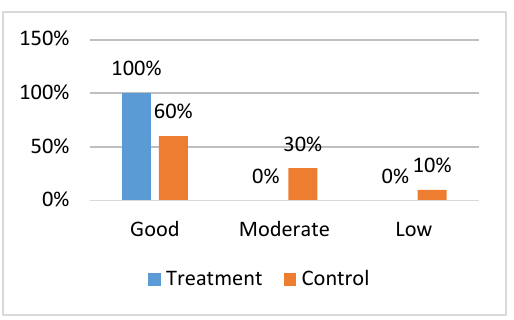
Figure 2 Self-care ability of respondents after Modeling participant